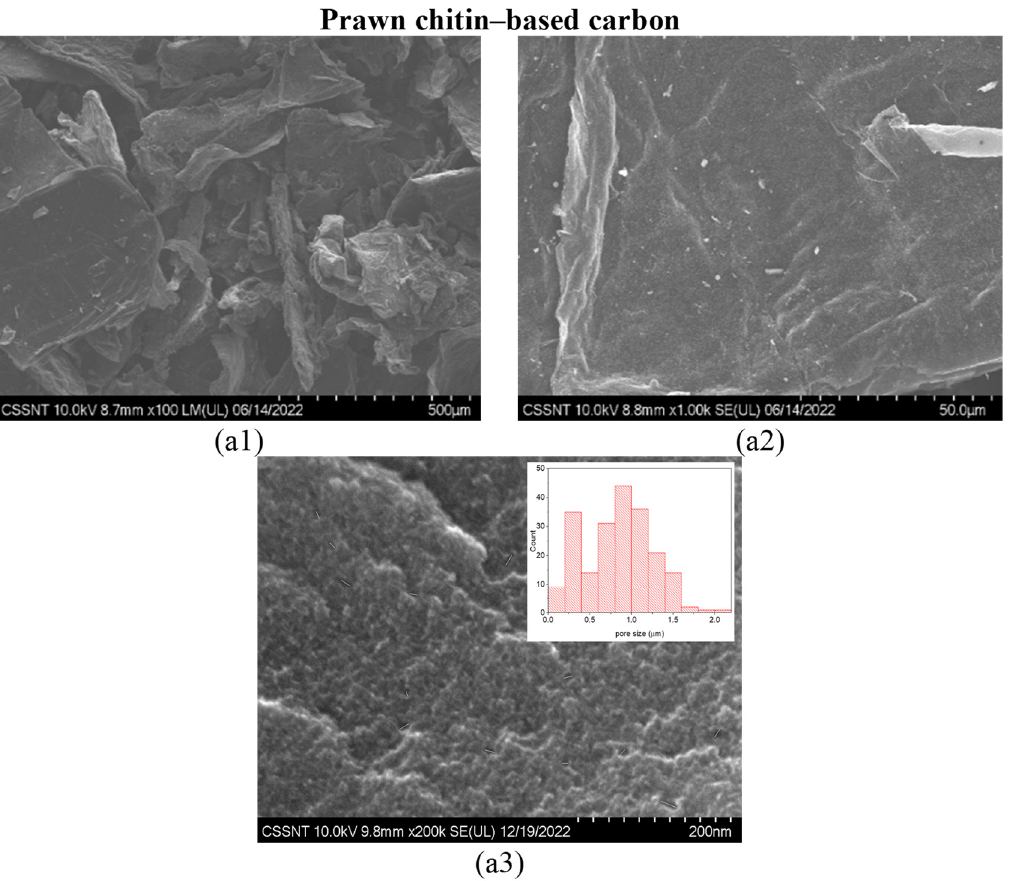
Figure 2. SEM images of prawn chitin-based carbons (carbonized at 1000 °C for 1 h) at different magnifications: ×100 ( a1 ), ×1 k ( a2 ), and ×200 k ( a3 ) with the pore size distribution in the inset of ( a3 ).